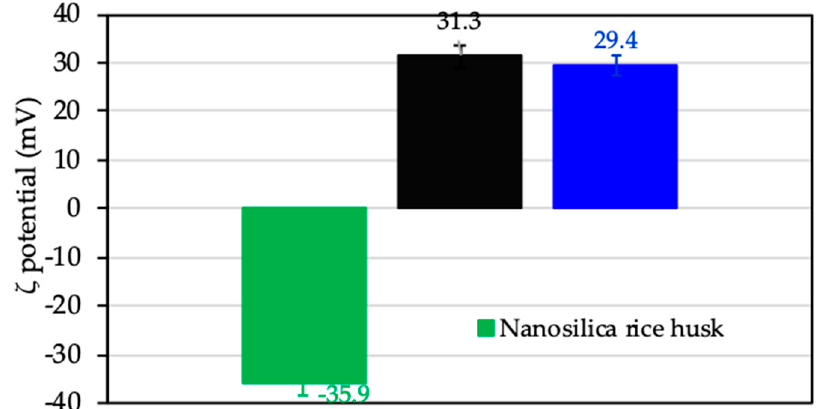
Figure 12. The ζ potential of nanosilica rice husk, protein-modified nanosilica (ProMNS), and ProMNS after CFX adsorption. Error bars show the standard deviations of three replicates.